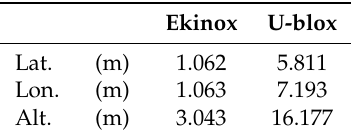
Table 7. RMSE from the two GNSS-only